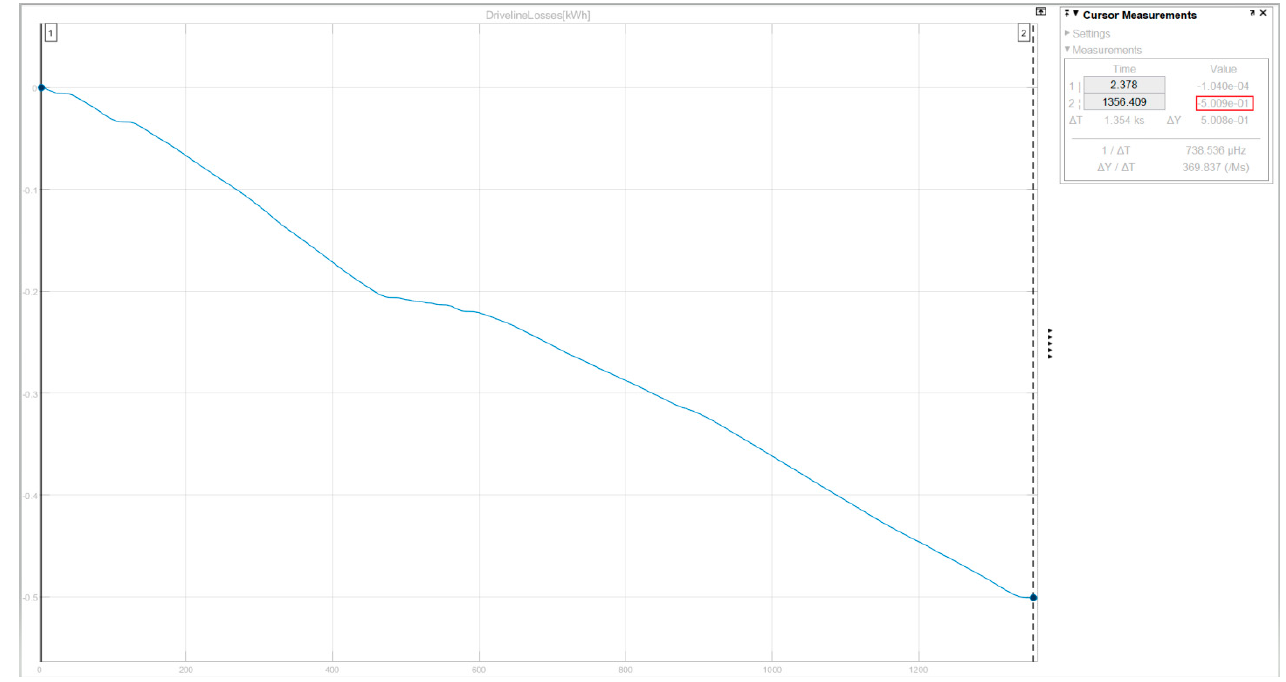
Figure 29. Driveline energy losses over time.